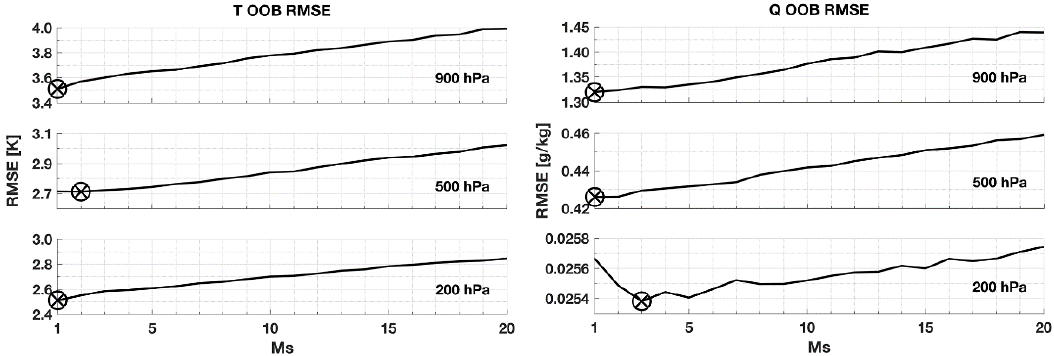
Figure 6. Ms parameter analysis for T ( left ) and Q ( right ) at three representative levels (top to bottom: 900, 500, and 200 hPa). The cross-circle markers indicate the selected values of the Ms parameter.